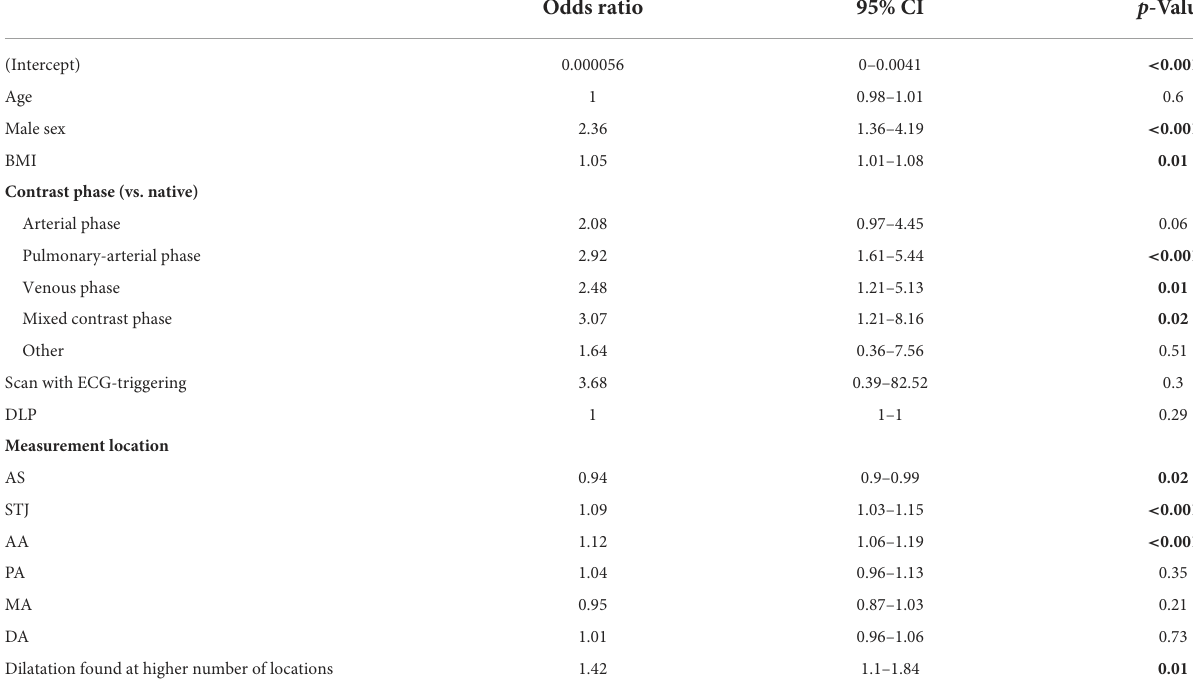
TABLE 5 MLRM 2 to differentiate between true positive vs. false positive